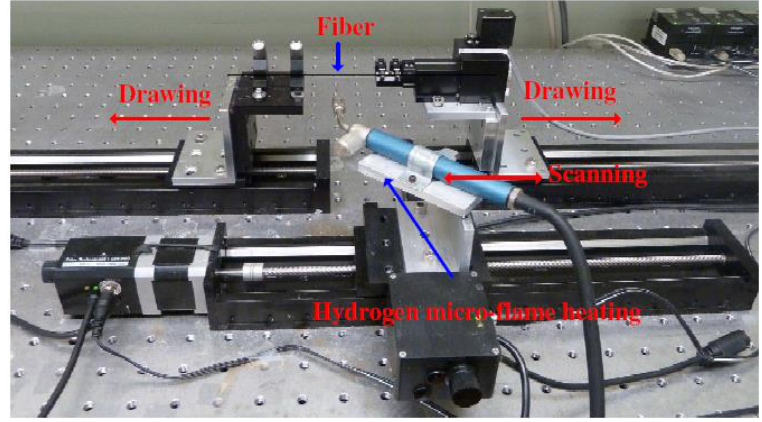
Figure 5. Experimental setup for H 2 flame heating and stretching technique [76].